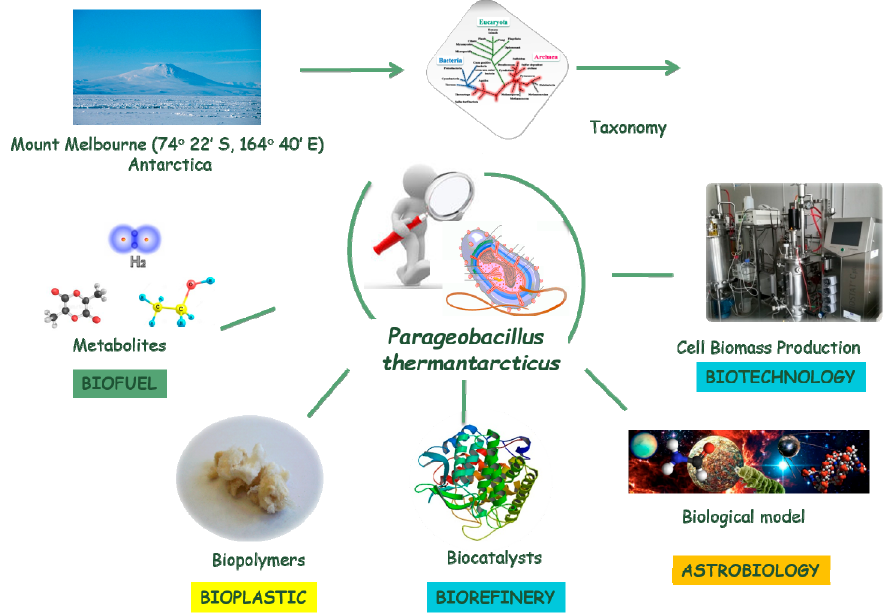
Figure 1. Parageobacillus thermantarcticus : a microbial cell factory.